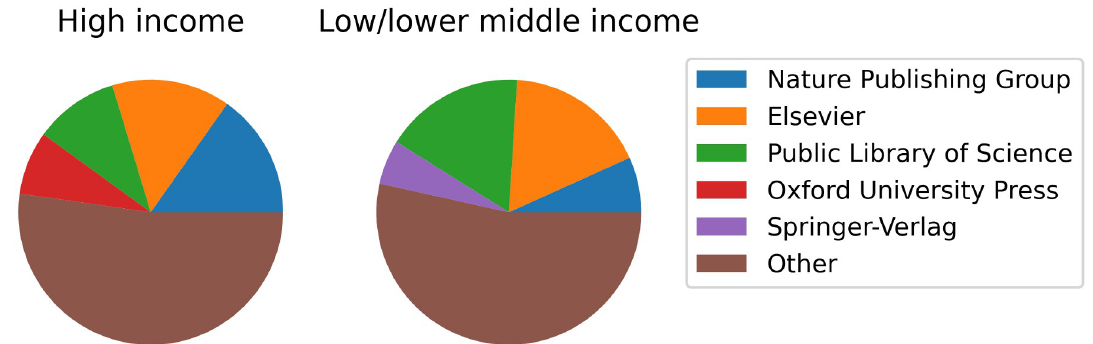
Fig 6. Top publishers from high and low/lower middle income groups. The top four publishers from each income group are shown. Oxford University Press is in the top four publishers of papers from high income countries, but not low/lower middle income countries, so it is only shown in one of the charts. Similarly, Springer-Verlag is only in the top four publishers of low/lower middle income countries.